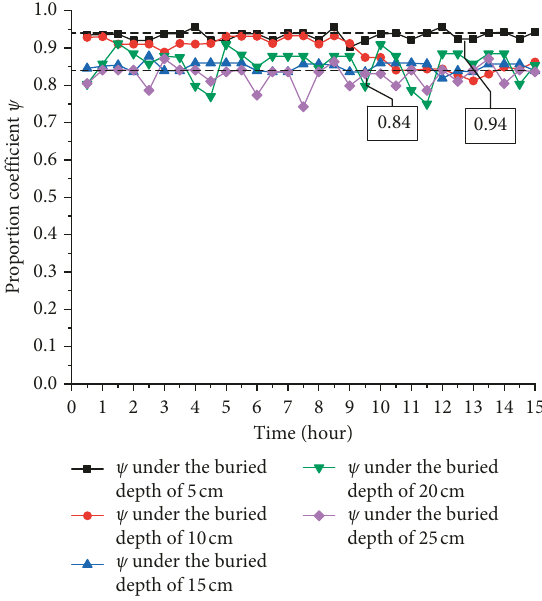
Figure 9: Variation of experimental groundwater buoyancy with the action time of groundwater pressure under different buried depths.